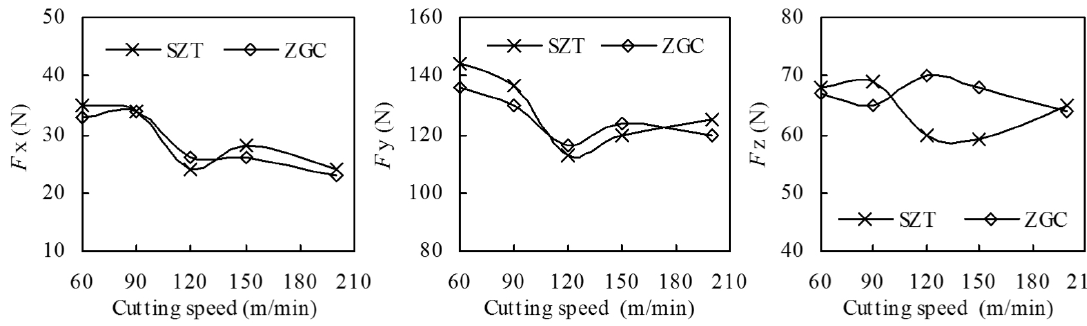
Figure 8. Effect of cutting speed on cutting forces of the ZrTiN-coated inserts ( a p = 0.15 mm, f = 0.10 mm/rev, cutting distance L = 300 m).